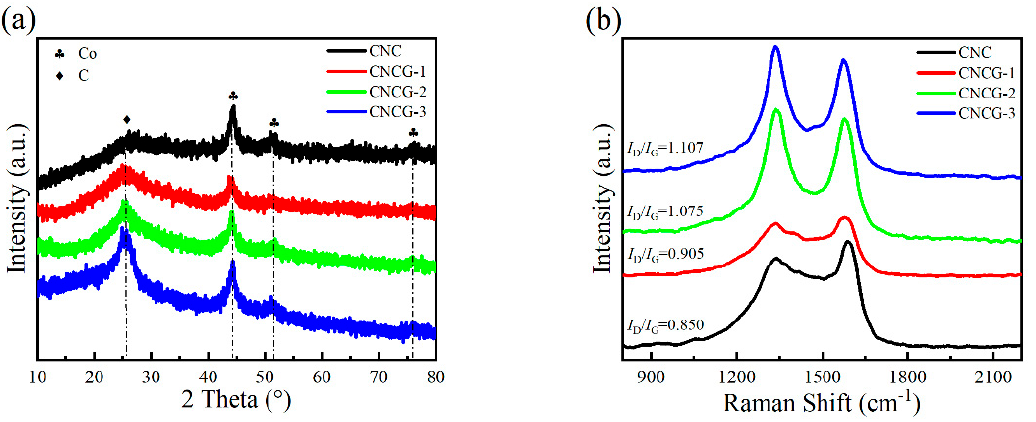
Figure 3. The XRD patterns and Raman spectra of all composites. ( a ) The XRD patterns of all composites; ( b ) The Raman spectra of all composites.